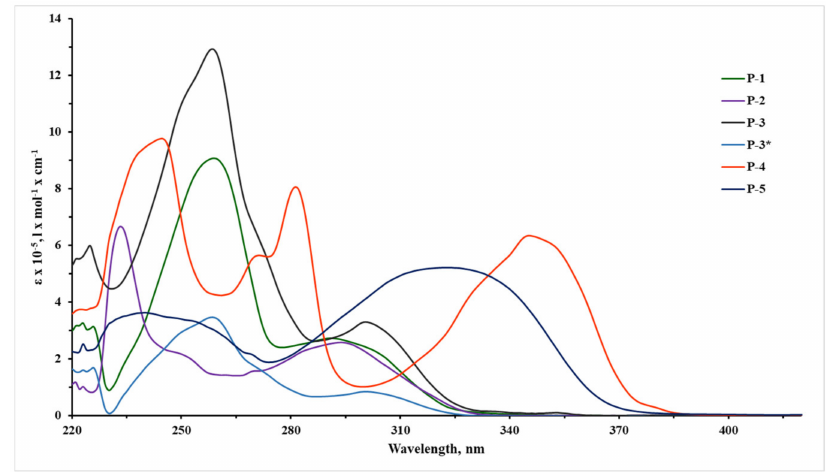
Figure 3. Absorption spectra of P1 – P5 in DCM solution.